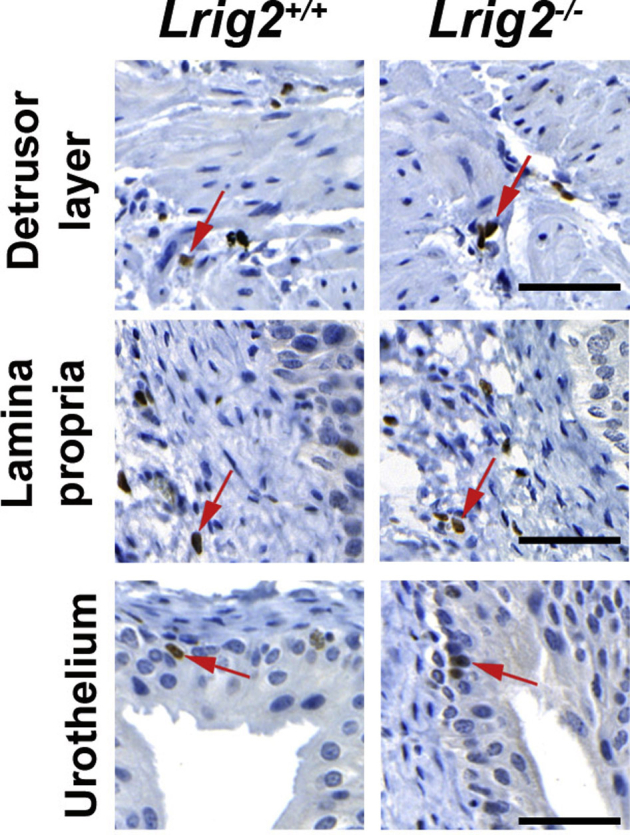
Ki67 immunostaining of adult bladders. All sections were counterstained with hematoxylin. Panels show high-power views of detrusor, lamina propria, and urothelial layers in wild types and mutants. Selections of nuclei positive for Ki67 are indicated by arrows. Bars are 50 = μm.